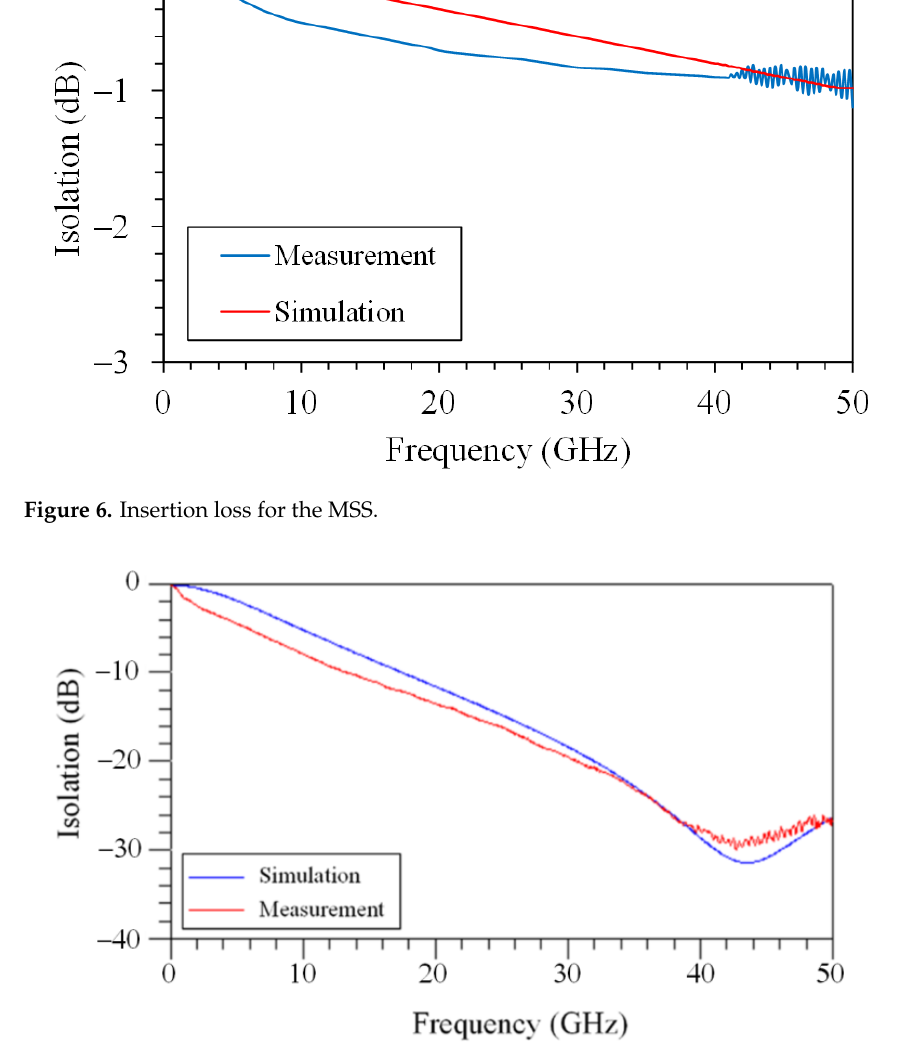
Figure 7. Isolation for the MSS 3. Fabrication of MMS The CMOS process and a post-process were used to make the MSS. Figure 8 illus- trates the MSS process flow. First, the Taiwan Semiconductor Manufacturing Company (TSMC) in accordance with the structure layout for the MSS as shown in Figure 1 employs a commercial CMOS process to manufacture the MSS. An optical microscope (Microtech LX500-M, M&T Optic Co. Ltd., Taiwan) was used to take the MSS image. Figure 9 shows an optical image for the MSS after the CMOS process. At this stage, the membrane and springs as shown in Figure 9 are not suspension structures because they are fixed by a sacrificial oxide layer. In order to obtain the suspension structures of the membrane and spring, the MSS requires a post-processing to remove the sacrificial oxide layer.